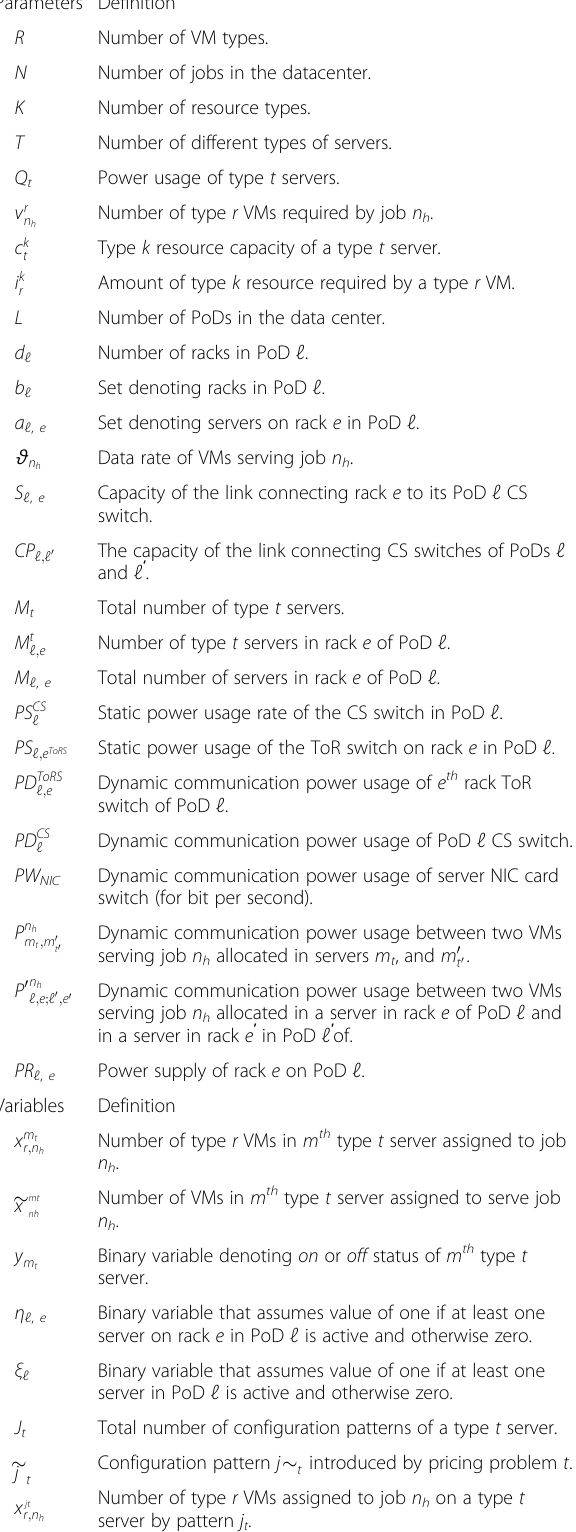
Table 1 Summary of notation Parameters Definition